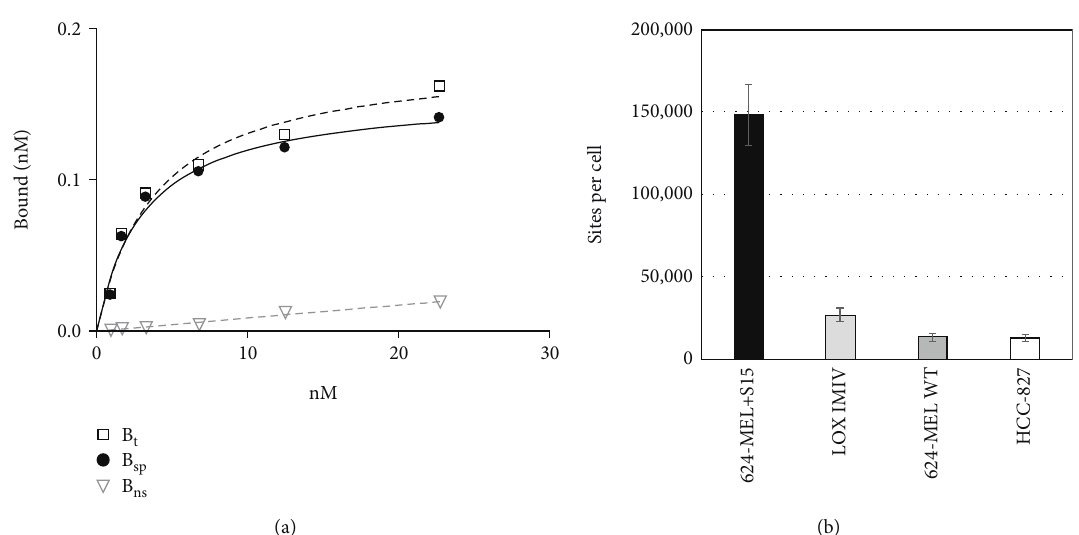
( B ) nonspecific ns , sites per cell) in 624- max